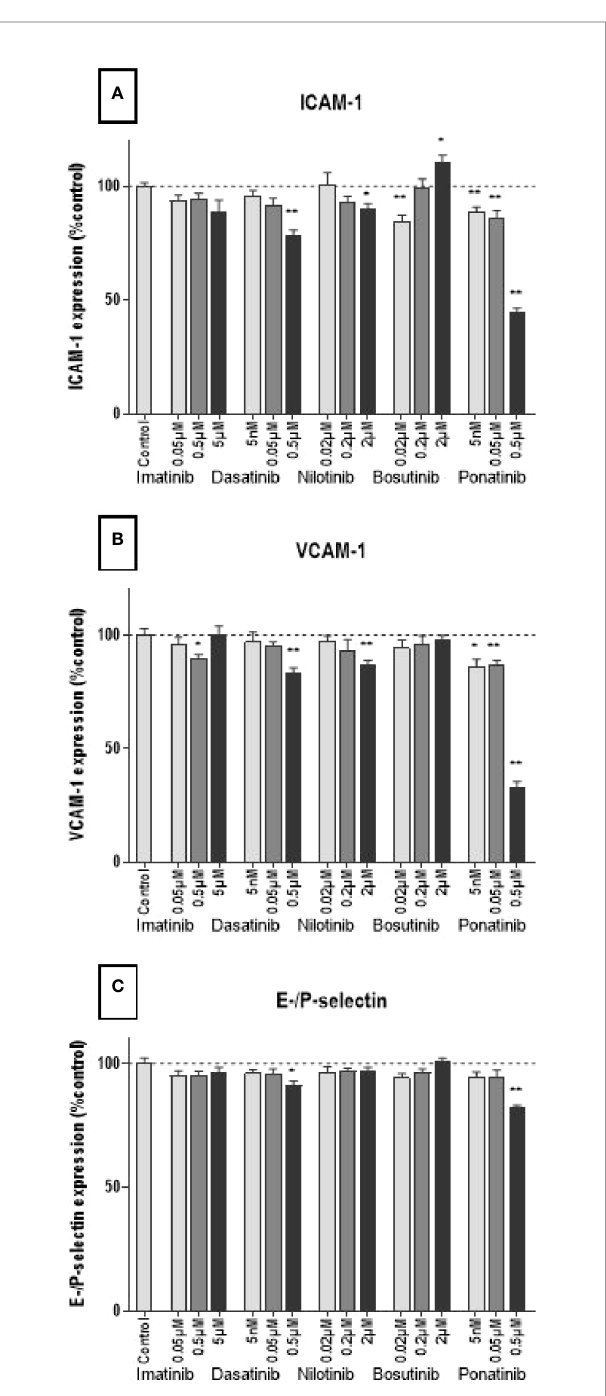
FIGURE 6 | BCR-ABL TKIs do not increase adhesion molecule expression on HUVECs. Expression of ICAM-1 (A) , VCAM-1 (B) , and E-selectin and P-selectin (C) by HUVECs after a 4-h activation by 10 ng/ml of TNF- a followed by a 24 h treatment with BCR-ABL TKI in medium without FBS. Data are presented as means of the absorbance ± SEM of n = 9 of three independent experiments (N = 3). Three concentrations were tested for each TKI. Results are expressed relative to control (DMSO 0.2%). Differences between conditions were tested using the Wilcoxon signed rank test. *p < 0.05 and **p <